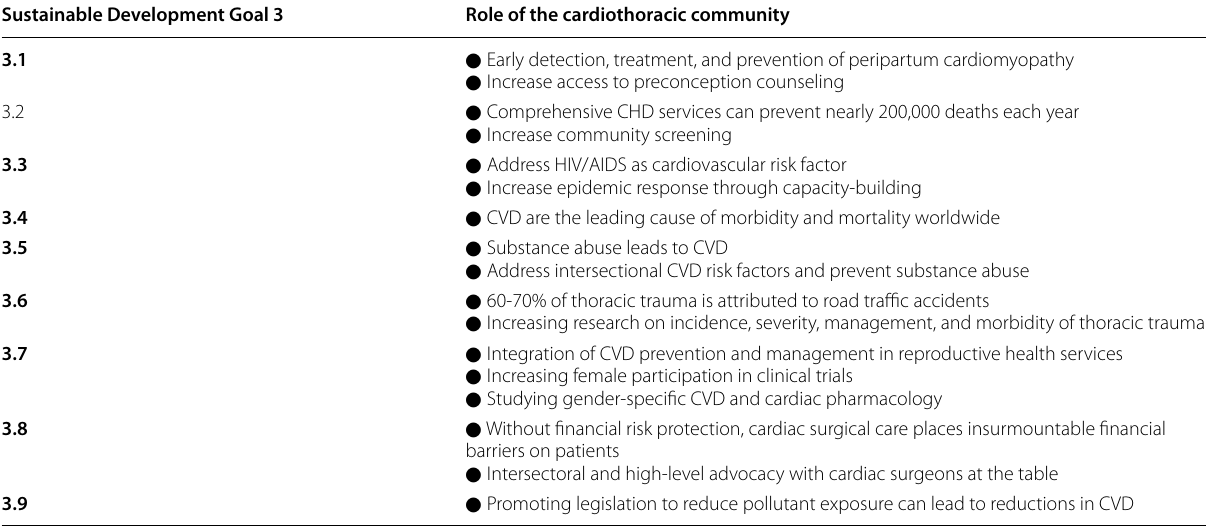
Table 2 Role of the cardiothoracic community in working towards Sustainable Development Goal 3 Sustainable Development Goal